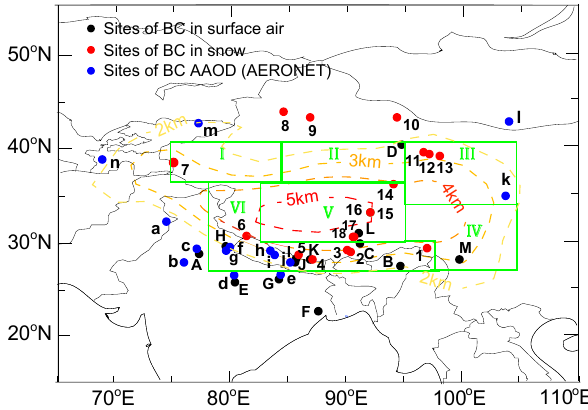
Figure 1. BC measurements at sites in and around the Tibetan Plateau (see also Tables 1, 2 and 3). Black circles are surface mea- surements: Delhi (A), Dibrugarh (B), Lhasa (C), Dunhuang (D), Kanpur (E), Kharagpur (F), Gandhi College (G), Manora Peak (H), Langtang (I), Nagarkot (J), Nepal Climate Observatory at Pyramid (NCOP, K), Nam Co Observational Station (NCOS, L), Zhuzhang (M). Red circles are measurements of BC in snow: Zuoqiupu (1), Qiangyong (2), Noijin Kangsang (3), East Rongbuk (4), Kang- wure (5), Namunani (6), Mt. Muztagh (7), Haxilegen Riverhead (8), Urumqi Riverhead (9), Miao’ergou No. 3 (10), Laohugou No. 12 (11), Qiyi (12), 1 July glacier (13), Meikuang (14), Tanggula (15), Dongkemadi (16), La’nong (17), Zhadang (18). Blue circles are BC AAOD measurements: Lahore (a), Jaipur (b), Gual_Pahari (c), Kan- pur (d), Gandi college (e), Nainital (f), Pantnagar (g), Jomsom (h), Pokhara (i), Kathmandu University (j), Semi-Arid Climate and En- vironment Observatory of Lanzhou University (SACOL, k), Dalan- zadgad (l), Issyk-Kul (m), Dushanbe (n). The rectangles are the six sub-regions: the northwestern plateau (I), the northern plateau (II), the northeastern plateau (III), the southeastern plateau (IV), the cen- tral plateau (V), and the Himalayas (VI). Topography is also shown (dashed colored